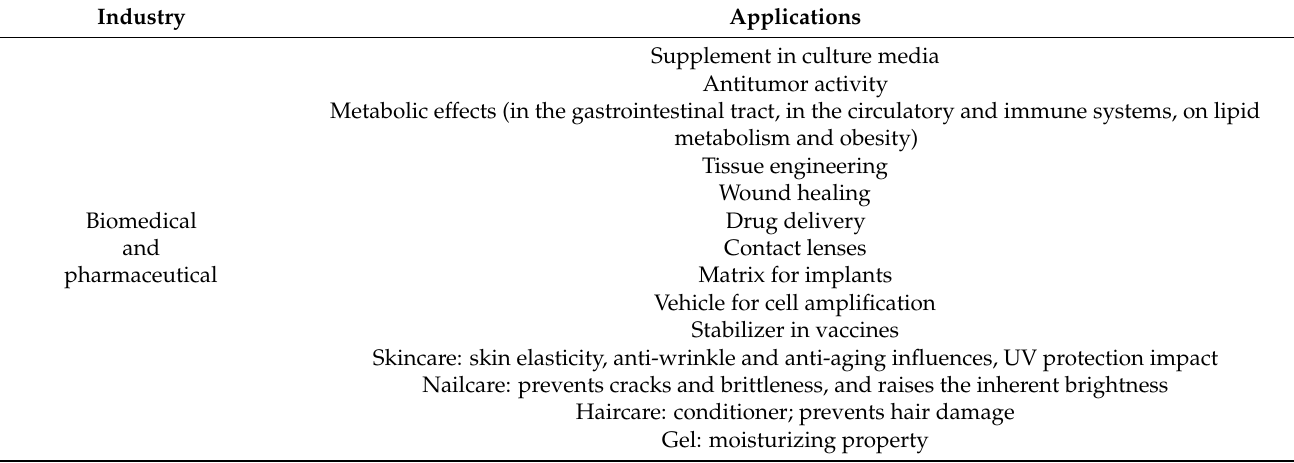
Table 6. Silk sericin applications in different industries. Adapted from